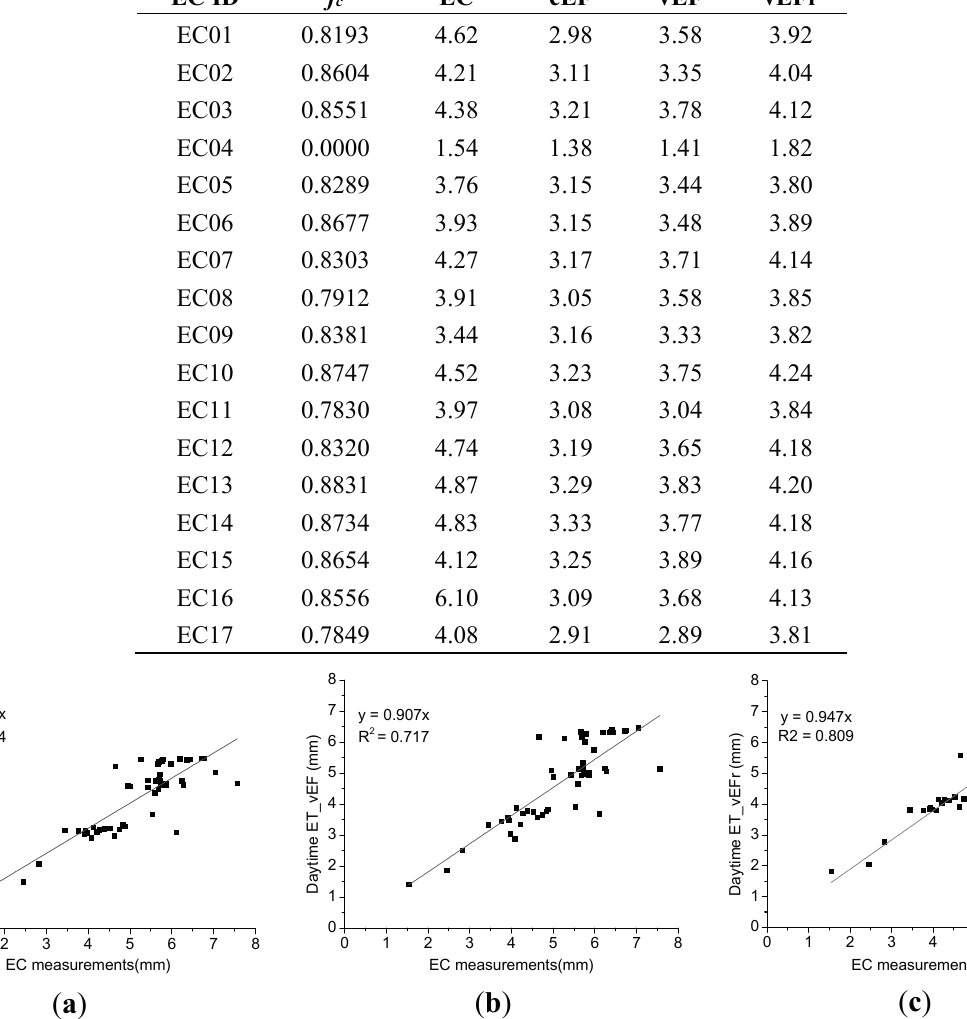
Table 6. ET validation on 11 August of 2012 (units: mm·d − 1 ).